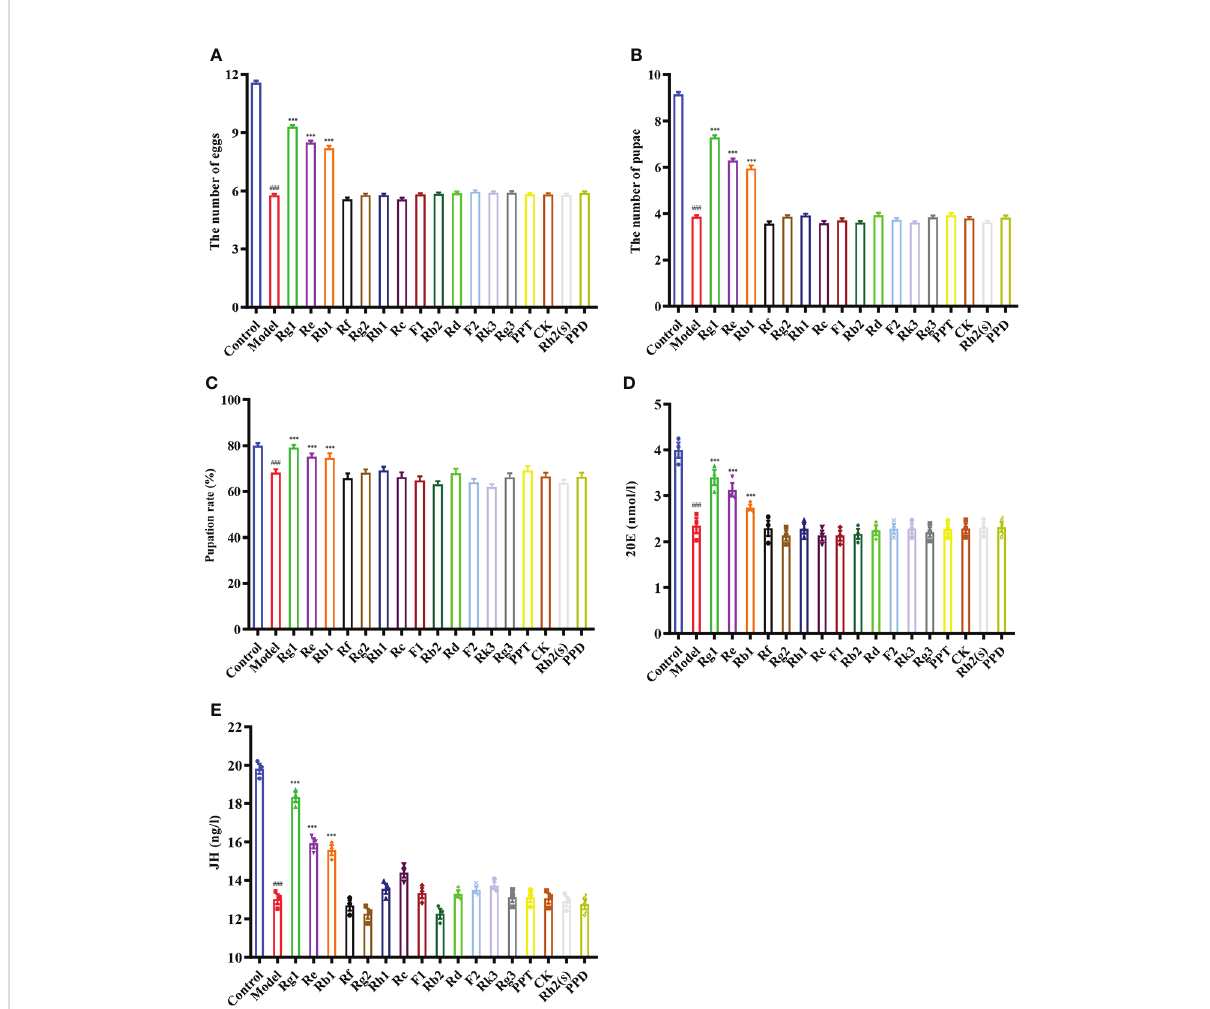
FIGURE 6 Effect of ginsenoside monomers on the reproductive ability and steroid hormone levels of Drosophila . (A) The number of eggs; (B) The number of pupae; (C) Pupation rate; (D) 20E content; (E) JH content; Rg1, 0.26 mg/mL; Re, 0.19 mg/mL; Rg2, 0.13 mg/mL; Rb1, 0.06 mg/mL; Rf, 0.03 mg/mL; Rh2(s), 0.02 mg/mL; Rh1, 0.02 mg/mL; PPT, 0.01 mg/mL; Rk3, 0.01 mg/mL; Rd, 0.007 mg/mL; Rc, 0.006 mg/mL; F2, 0.004 mg/mL; Rb2, 0.004 mg/mL; CK, 0.003 mg/mL; F1, 0.003 mg/mL; PPD, 0.002 mg/mL; Rg3, 0.001 mg/mL; according to the concentration ratio of ginsenosides at 1 mg/mL. ### p <0.001 compared with control (7-day-old female Drosophila ); *** p <0.001 compared with model (35-day-old female Drosophila